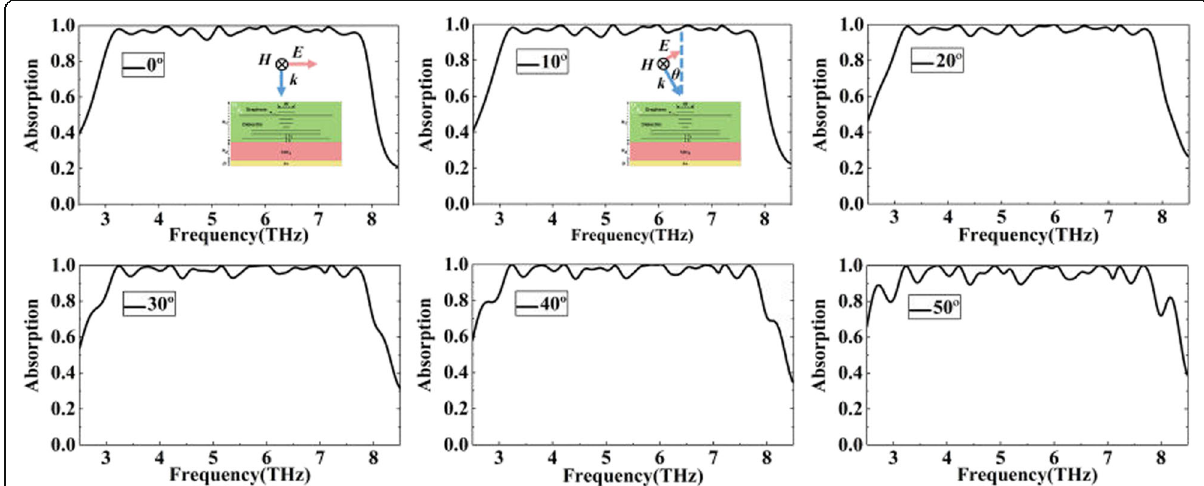
Fig. 8 The calculated absorption spectra of the absorber with different incident angles